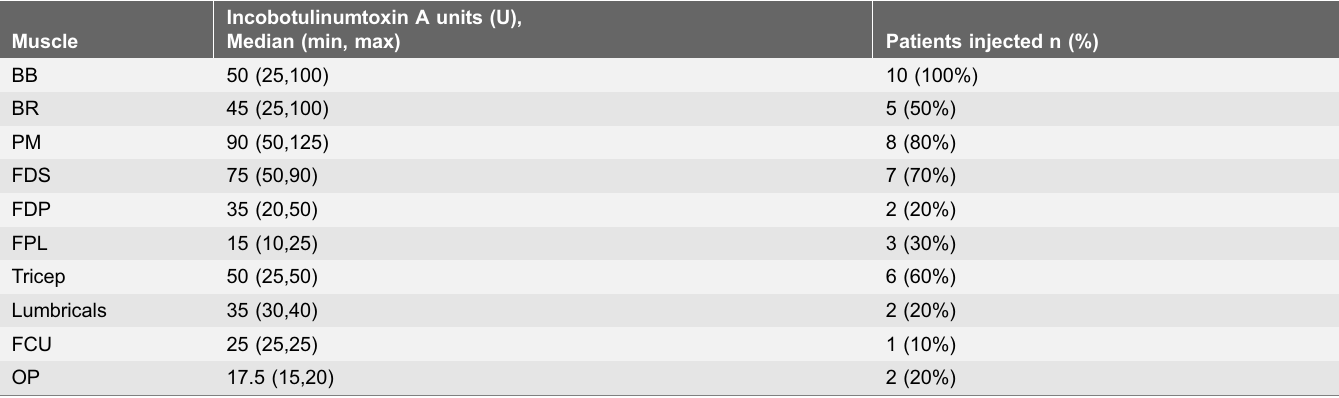
Table 3. Muscles and doses injected.